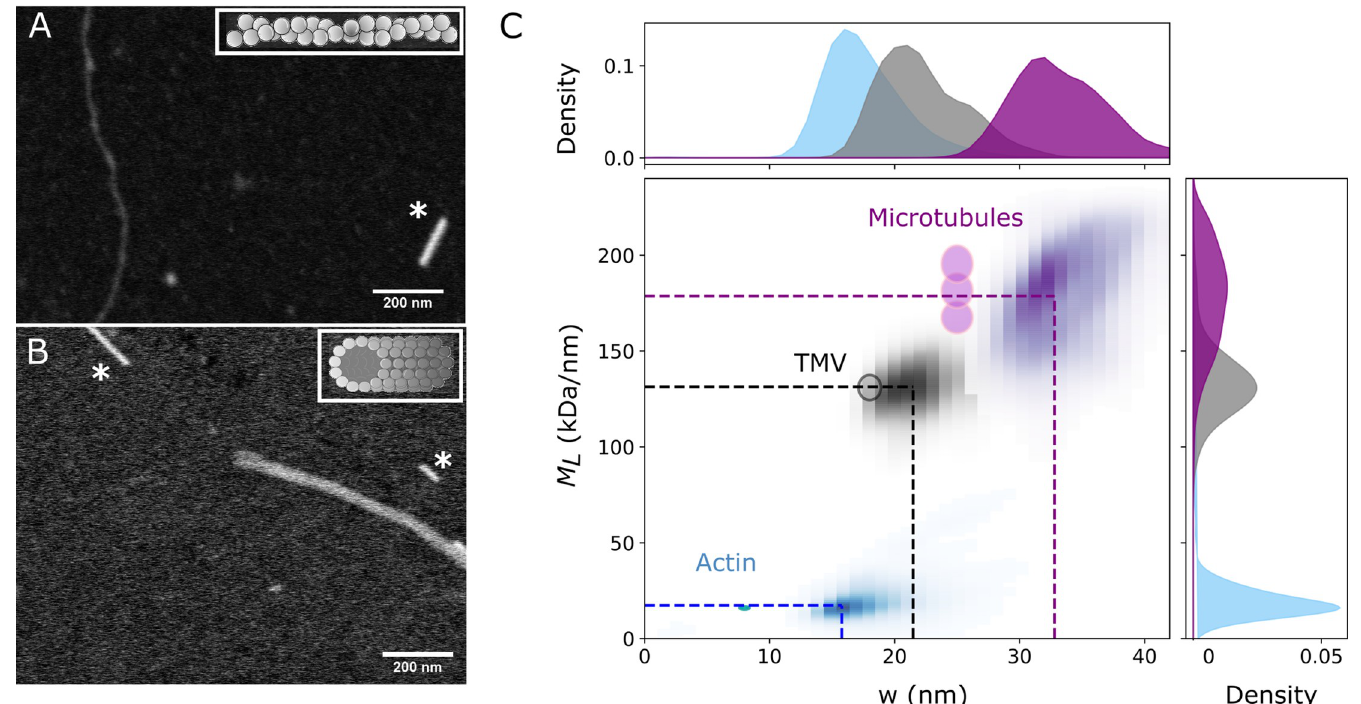
Fig 2. Mass mapping of cytoskeletal proteins. Unprocessed images of (A) an actin filament and (B) a microtubule. The short bright rods marked by an asterisk in both images are TMV rods used as reference. (C) Kernel density plot of the filament mass per length ( M microtubules (purple), TMV (black) and actin (blue). The dotted lines show the mean fitted values, and the circles indicate the expected values from literature with a ± 10% spread. For microtubules, the three circles correspond to structures with 12, 13, and 14 protofilaments. n = 8150 (actin), 2986 (microtubules), 5450 (TMV)